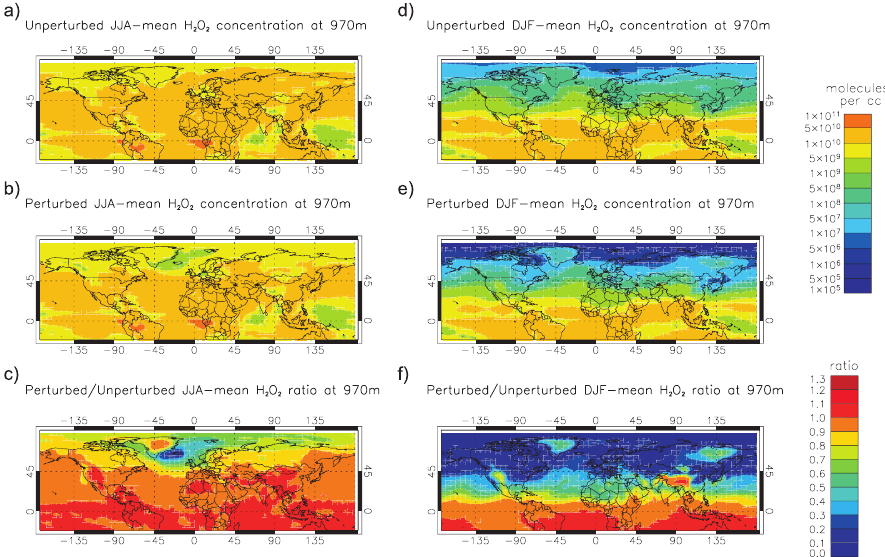
Fig. 6a. Simulated 3-month mean H 2 O 2 concentration at low-level cloud altitude (970m) for (a) L-s unperturbed run, (b) L-s perturbed run, (c) L-s ratio perturbed to unperturbed run, (d) L-w unperturbed run, (e) L-w perturbed run, (f) L-w ratio perturbed to unperturbed run. JJA=June-July-August;